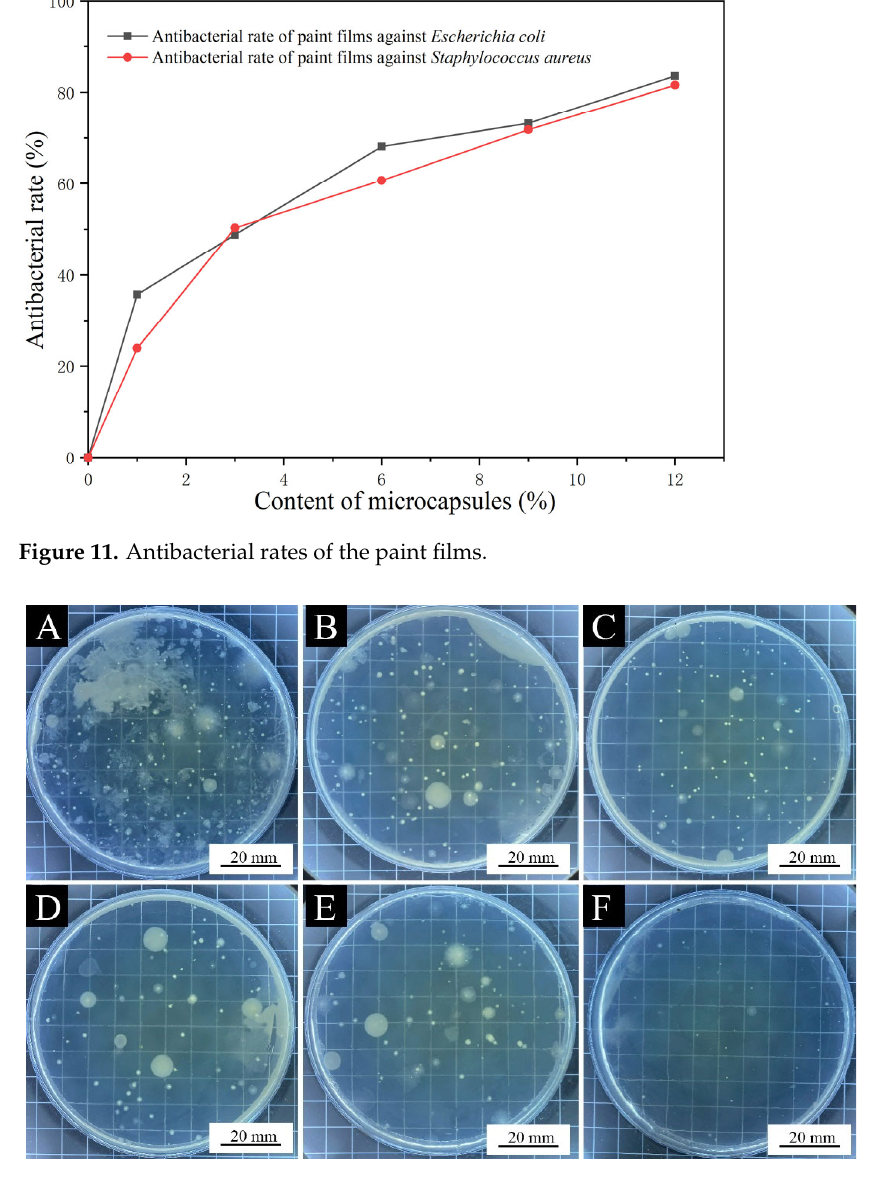
Figure 12. Escherichia coli colonies recovered after antibacterial test of the paint films: ( A ) 0% microcapsule ‐ loaded film, ( B ) 1.0% microcapsule ‐ loaded film, ( C ) 3.0% microcapsule ‐ loaded film, ( D ) 6.0% microcapsule ‐ loaded film, ( E ) 9.0% microcapsule ‐ loaded film, and ( F ) 12.0% microcapsule ‐ loaded film.